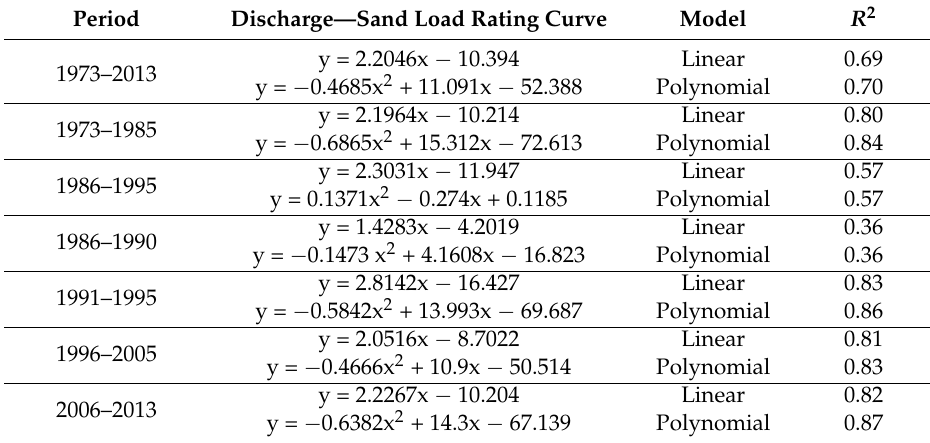
Table 1. Discharge-sand load rating curves developed for Tarbert Landing of the Lowermost Mississippi River (LmMR). Here, x = ln daily discharge ( Q d ) (the independent variable) and y = ln daily sand load ( DSL ) (the dependent variable).